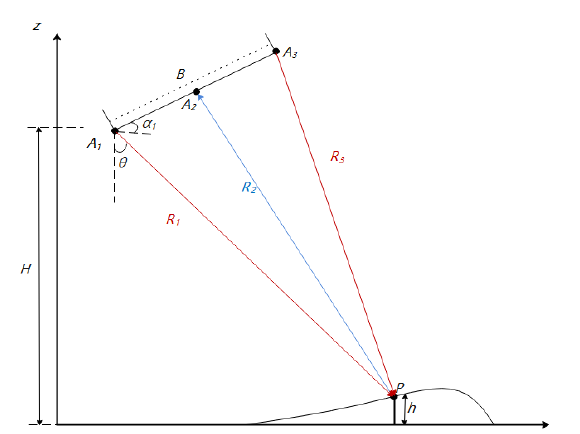
Figure 2. The measurement geometry of three channel calibration of airborne array flexible